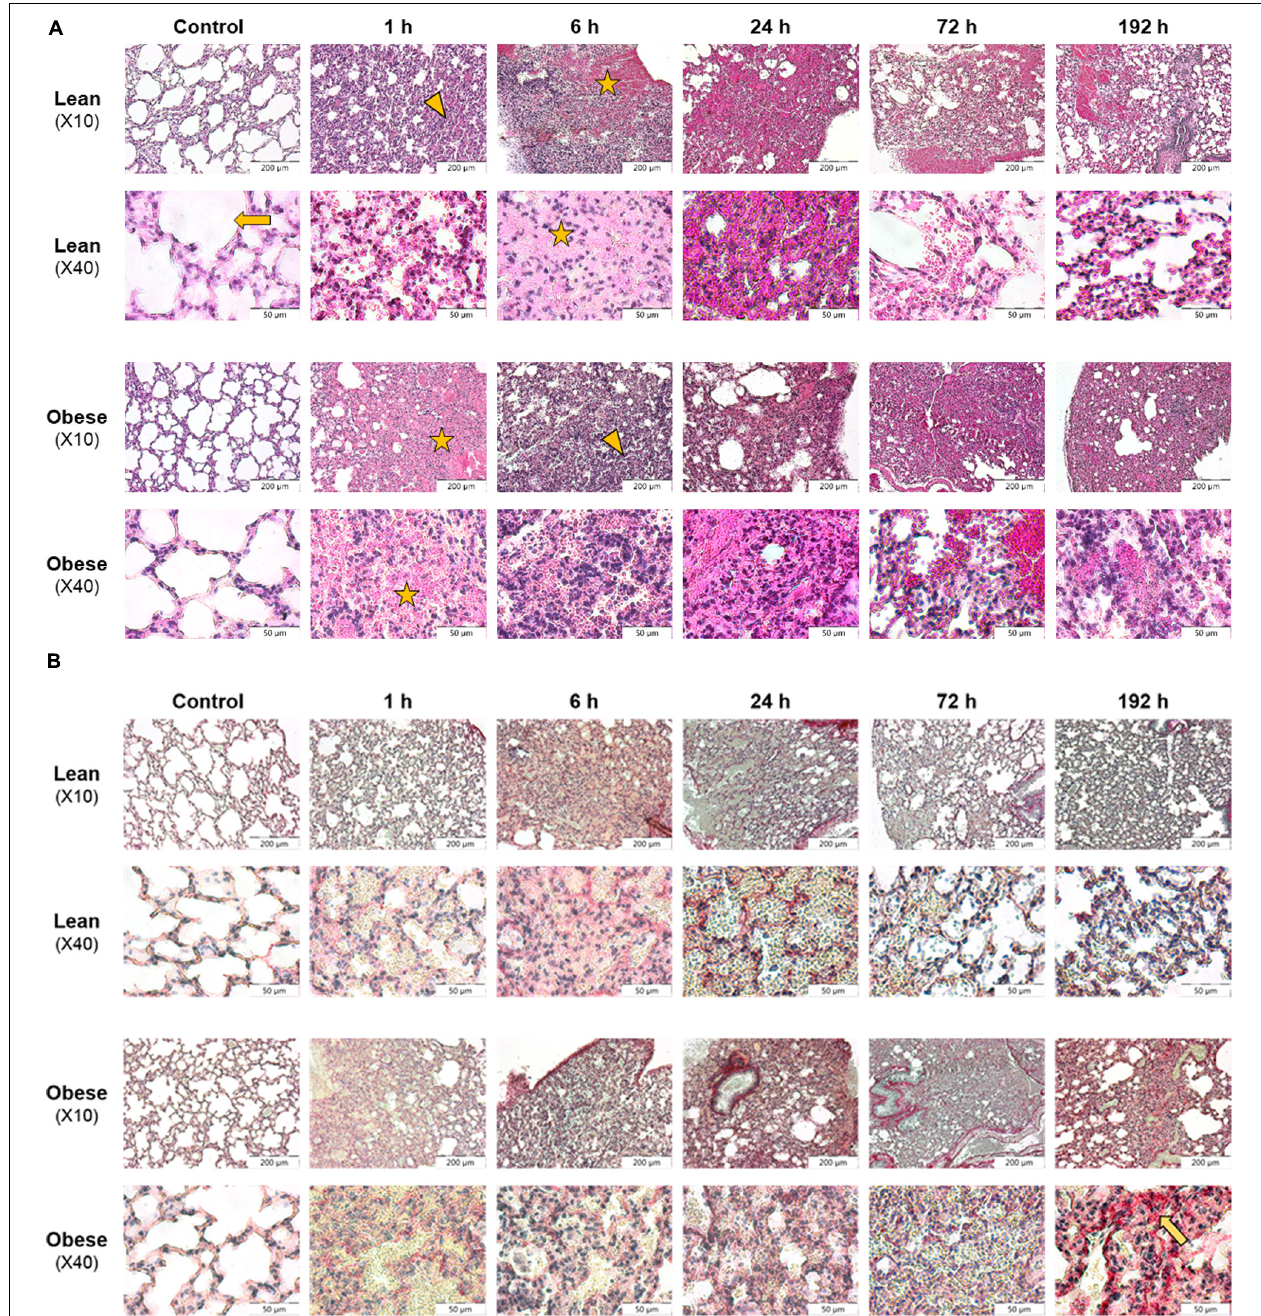
FIGURE 1 | Morphological evaluation of lung shows restricted clearance of tissue debris in obese mice 192 h after trauma induction. Histology of regeneration process in lung of male lean and obese C57BL/6J mice after induction of blunt thorax trauma ( n = 6). (A) Hematoxylin and eosin (HE) staining of lung tissue sections from control animals as well as 1, 6, 24, 72, and 192 h post trauma. Blunt injury led to alveolar (arrow) influx of erythrocytes (asterisk) 1 h post trauma. Further, alveolar contusion (triangle) and influx of immune cells was visible. (B) Sirius red (SR) staining of lung tissue sections from control animals as well as 1, 6, 24, 72, and 192 h post trauma. Interstitial collagen deposition (arrow) was visible 192 h post injury, elevated in obese animals. Pictures were taken with the UC30 color camera at X10 and X40 magnification (OLYMPUS IX81). Scale bar: 200 µ m (X10), 50 µ m (X40).